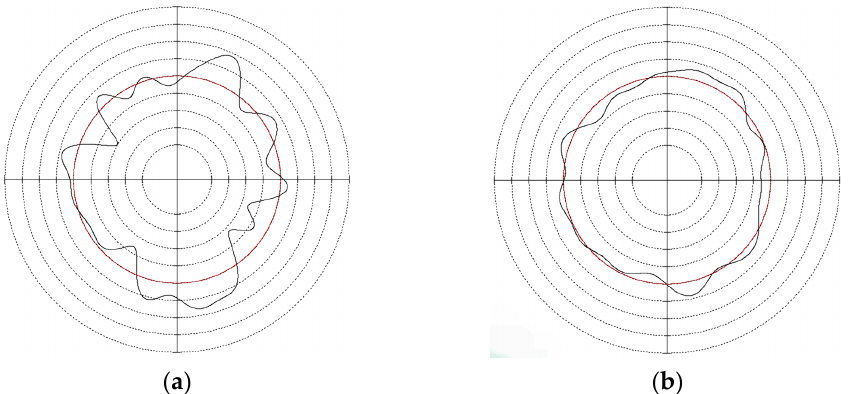
Figure 12. Roundness profile of workpiece after machining: ( a ) centerless grinding; ( b ) electrochem- ical mechanical machining.